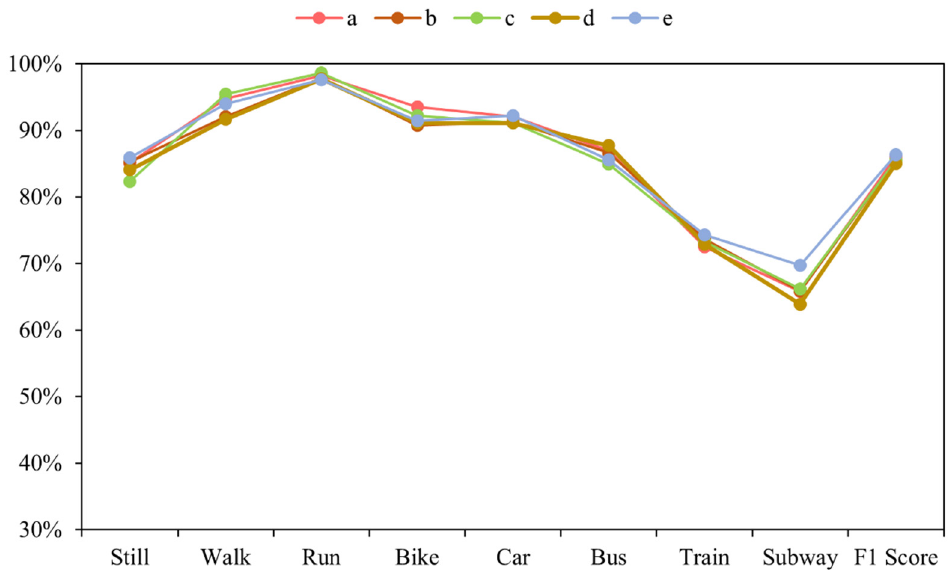
Figure 15. F1 scores were obtained by setting four different sets of hyperparameters (a–e) in the Temporal Block.